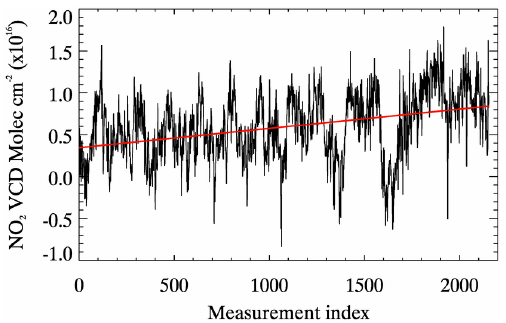
Figure 16. VCD measurements as a function of measurement index (time) with line of best fit presented in red. Measurements were averaged over ± 30 pixels from the nadir, taken from 12:43 to 13:43.